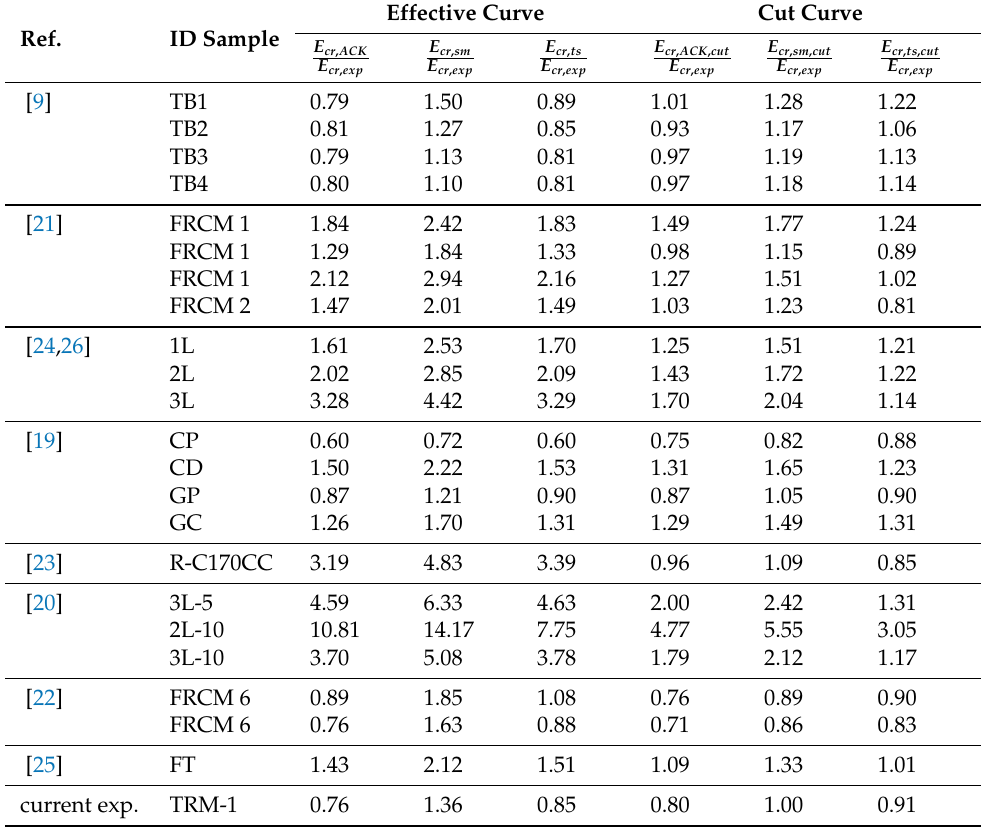
Table 4. Experimental-theoretical comparison.